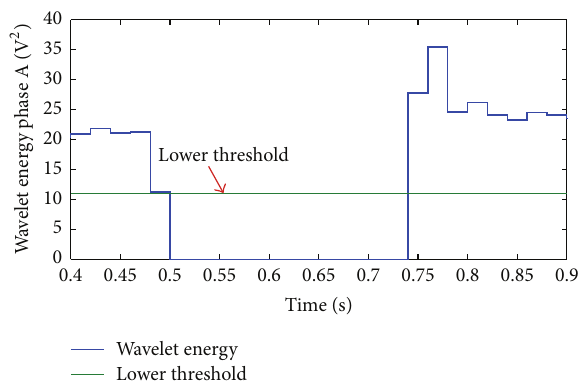
Figure 18: Threshold